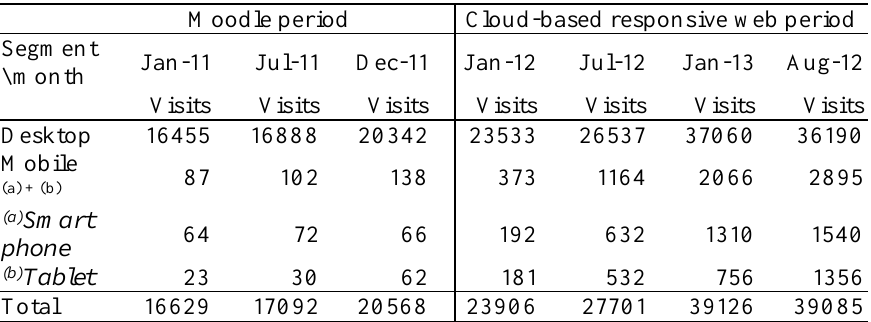
Table 5 Trends of Visits via Desktop, Smart Phone, and Tablet in the Moodle-Based Platform and Cloud-Based Responsive Web Platforms Moodle period Cloud-based responsive web period Segment